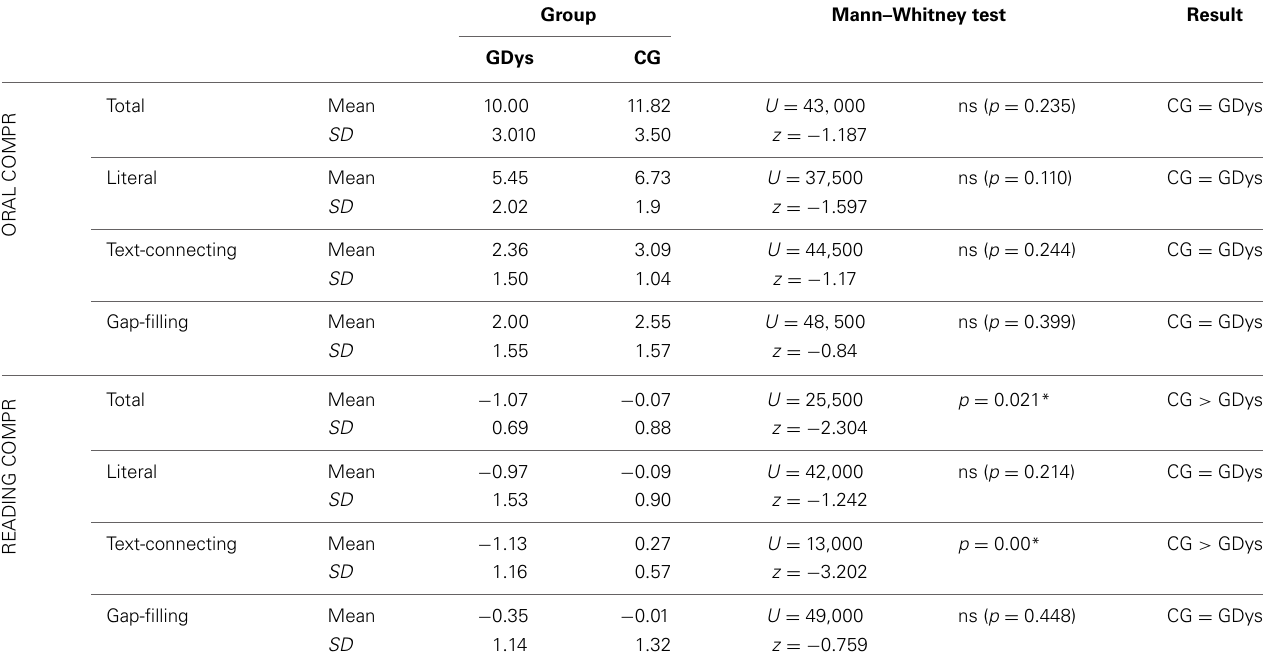
Table 2 | Comparison of performances obtained in oral and reading comprehension tasks.